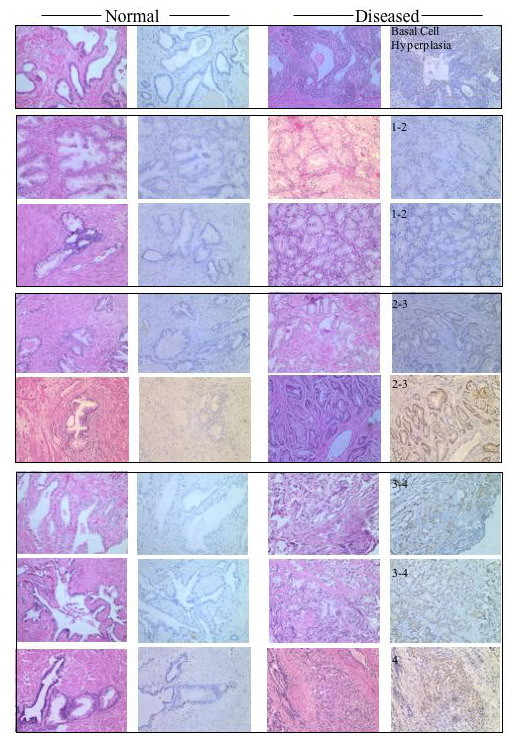
Immunohistochemical staining of EphB4 in prostate cancer samples. The expression of EphB4 in human prostate carcinomas was detected using immunohistochemical staining of formalin fixed, paraffin-embedded tissue samples. Images (20× magnification) of normal (panel 2) and diseased tissue (panel 4) from eight different patient samples are shown with a Haematoxylin/eosin stained consecutive section (panels 1 and 3). The Gleason score for each disease focus is shown in the top left-hand corner of the image of each tumour focus. A single sample that contained a focus of basal cell hyperplasia, two samples with well-differentiated adenocarcinoma, two samples of moderately differentiated adenocarcinoma and three samples of poorly differentiated adenocarcinoma are shown. The brown stain from the biotinylated secondary antibody indicates the EphB4 protein. Nuclei are stained with Harris haematoxylin and appear blue. Staining of normal tissues was either absent or weak and diffuse. Increased staining of the tumour tissue appeared to correlate with increased Gleason score. There was no cross-reactivity with the secondary antibody alone (result not shown).